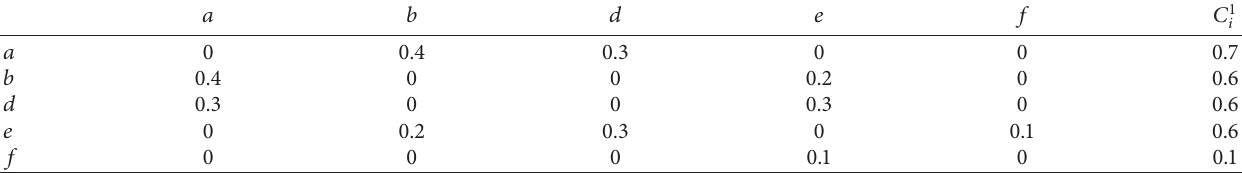
Table 4: The tabular representation of Z ∗ ( e ) with choice